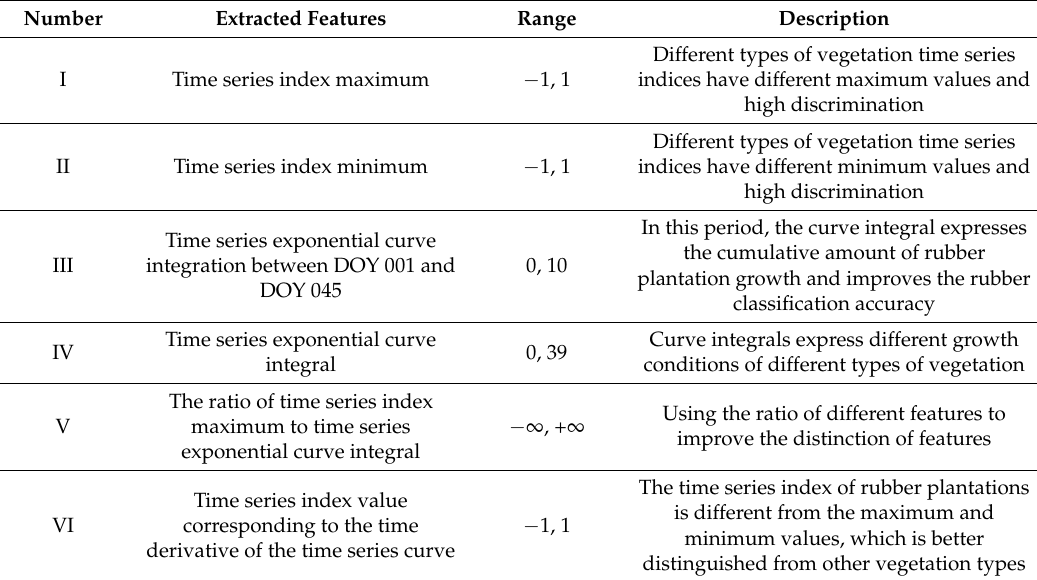
Figure 4. Time series EVI curve of rubber plantations and curve features. Table 5. Classification features of rubber plantations based on EVI time